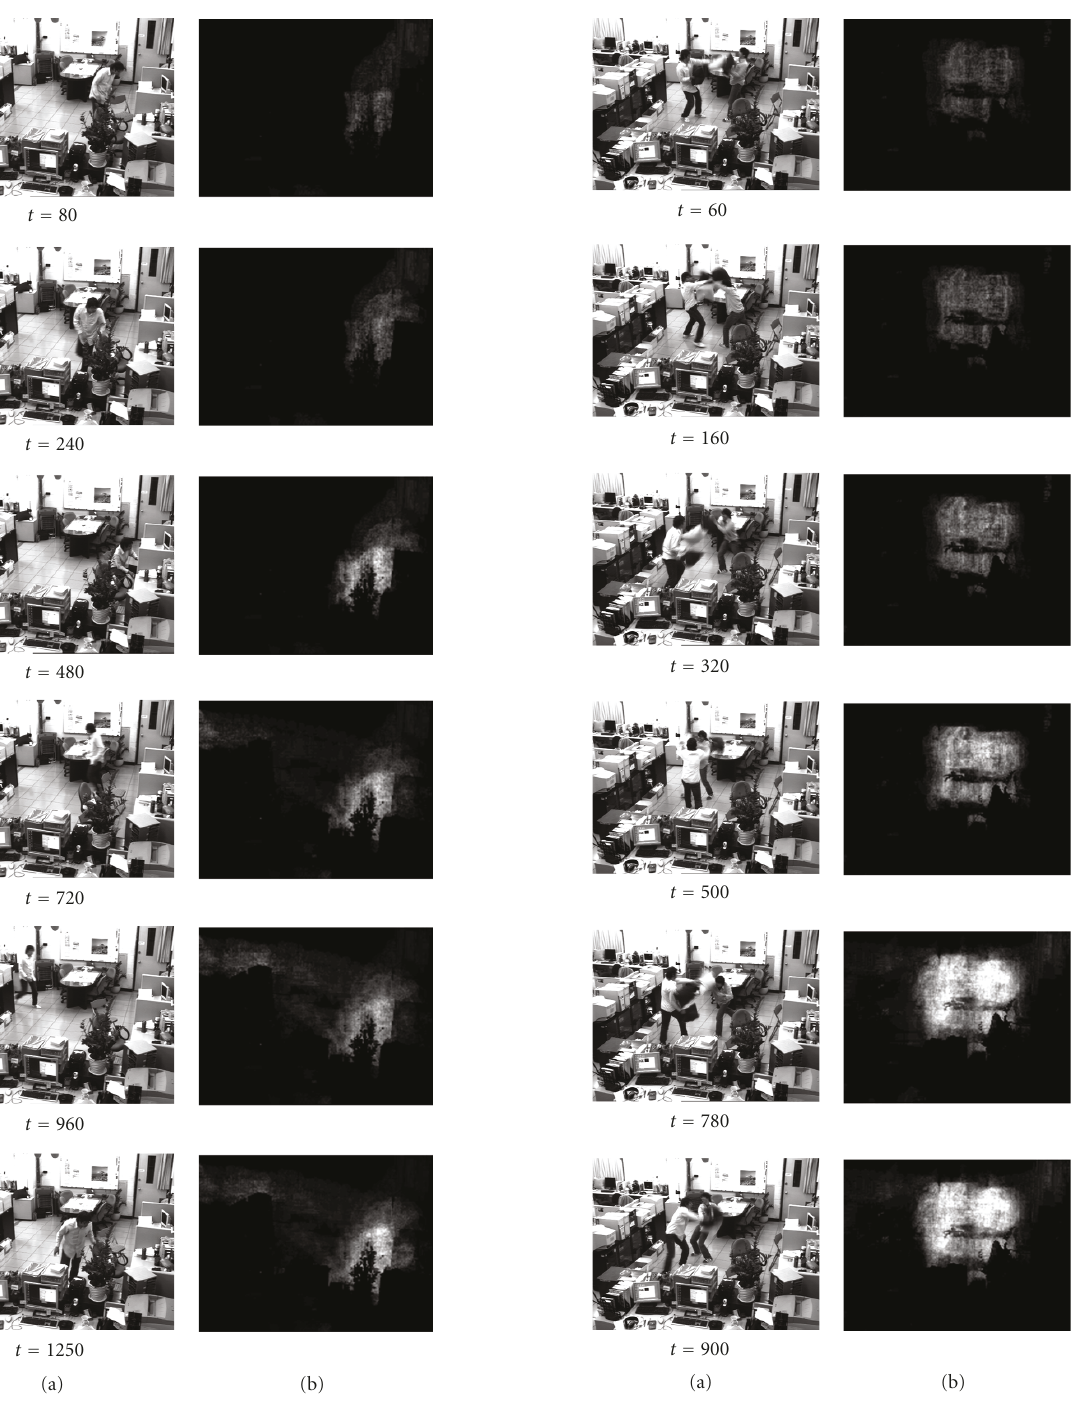
Figure 4: Abnormal event of a burglary scenario: (a) discrete image frames in the sequence; (b) corresponding energy maps. (symbol t represents the frame number in the sequence with fps = 10).